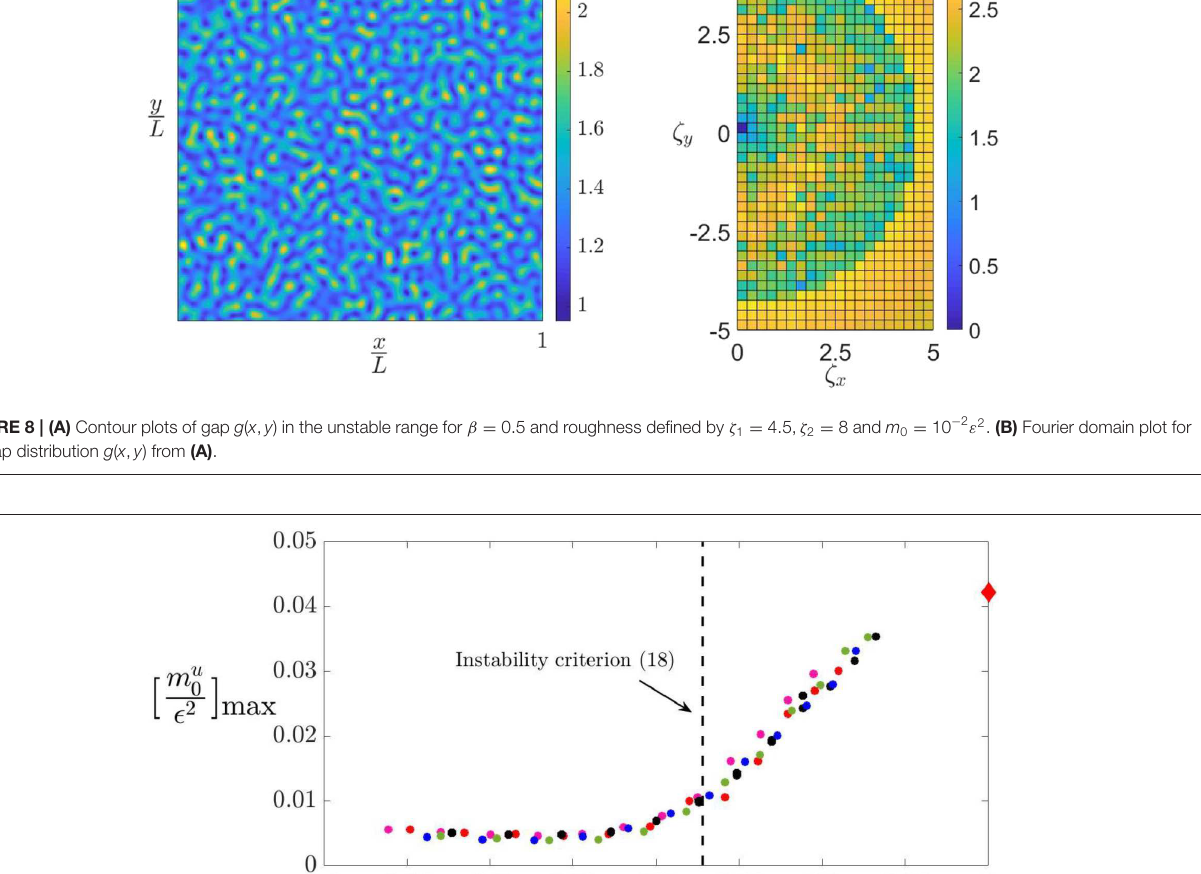
FIGURE 9 | Normalized spectral content [ m u 0 /ε 2 ] for the gap g ( x , y ) in the unstable wavenumber range as a function of the maximum negative slope of the modified max g )] σ ′ M ( traction law [ . Consistency between several roughness spectra shows that [ max ¯ − at the top right defines [ m u 0 /ε 2 ] for a smooth layer. max